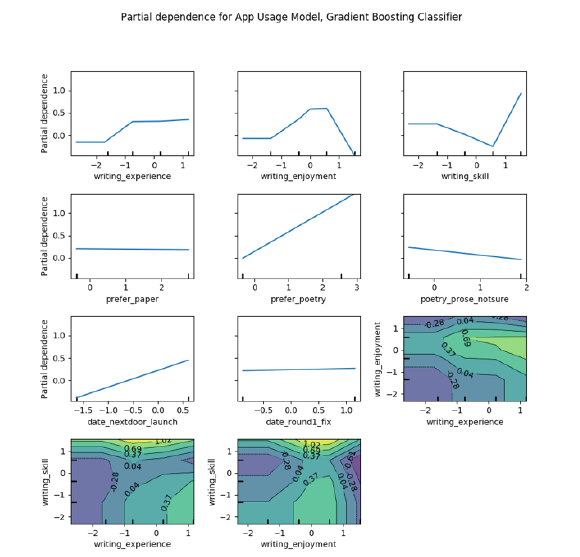
Figure 30. Partial dependence for Question 8